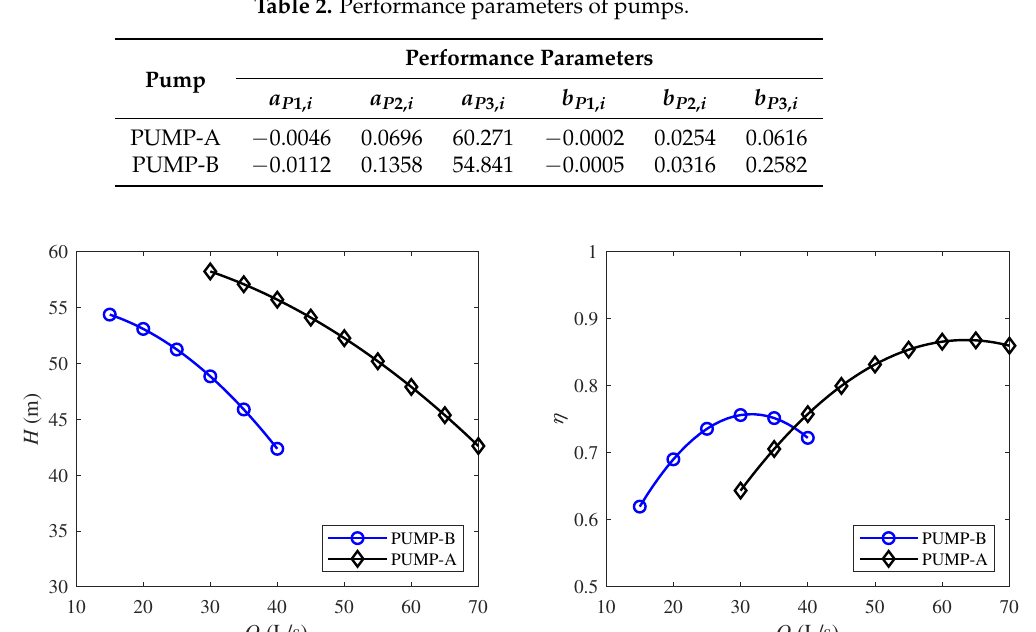
Figure 4. The performance curves of PUMP-A and PUMP-B.